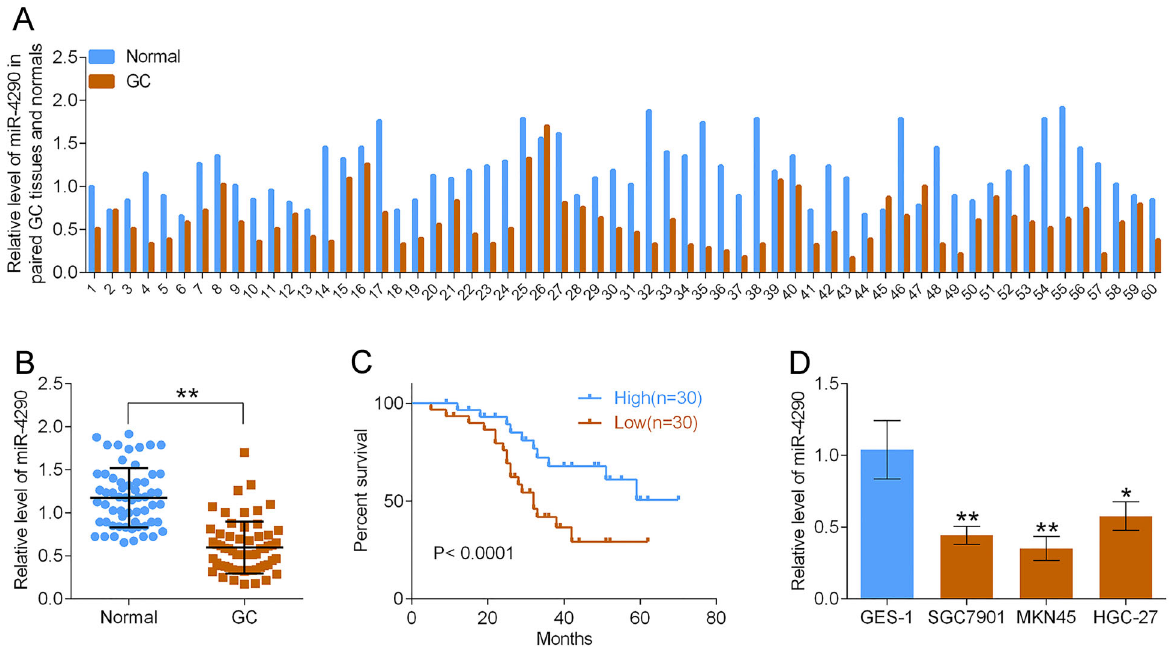
Figure 1. miR-4290 was lowly expressed in gastric cancer (GC) tissues and cells and closely associated with the overall survival of patients. A and B , The expression levels of miR-4290 in 60 GC tissues and the matched normal tissues were detected by RT-PCR assay. C , Kaplan-Meier analysis of the relationship between the expression levels of miR-4290 and patients ’ overall survival. D , RT-PCR assay was used to detect the expression of miR-4290 in GES-1, SGC7901, MKN45, and HGC-27 cell lines. Data are reported as means ± SD (n=3). *P o 0.05, **P o 0.01